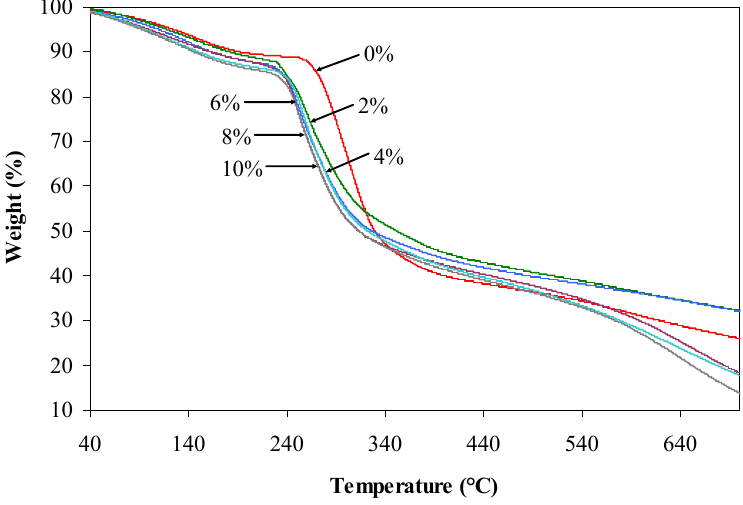
Figure 5. Derivative thermograms (DTG) of the agarose/talc composite